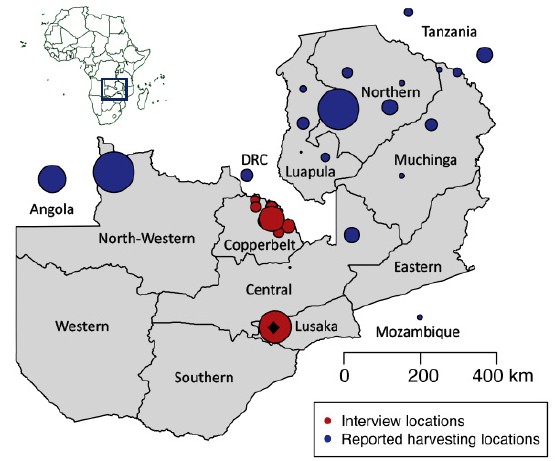
Figure 1. Map of Zambia with an overview of interview localities and reported provenance of the chikanda tubers. Dot size corresponds to the number of informants.